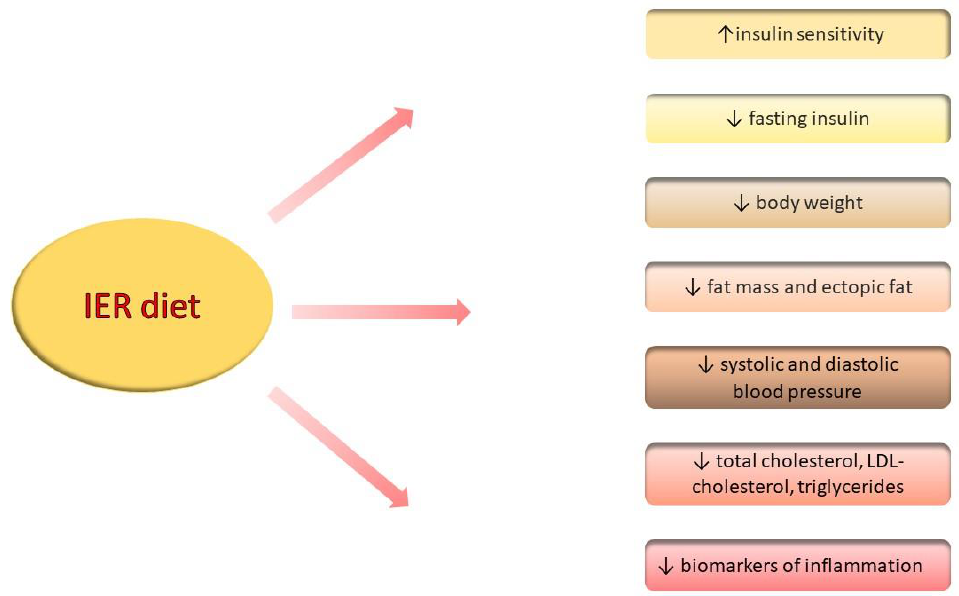
Figure 3. The effect of IER diet on different metabolic and inflammatory parameters ( ↑ - increase, ↓ - decrease/reduction).